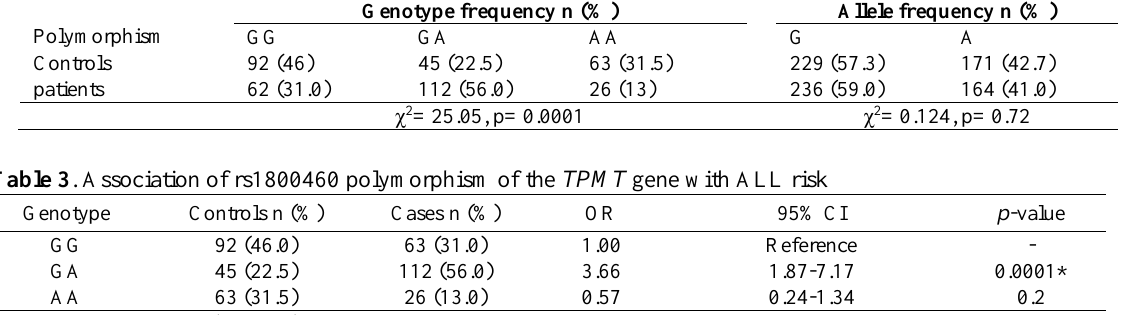
Table 2. Genotype and allele frequency rs188460 polymorphism of the TPMT gene among the studied population. Genotype frequency n (%) Polymorphism